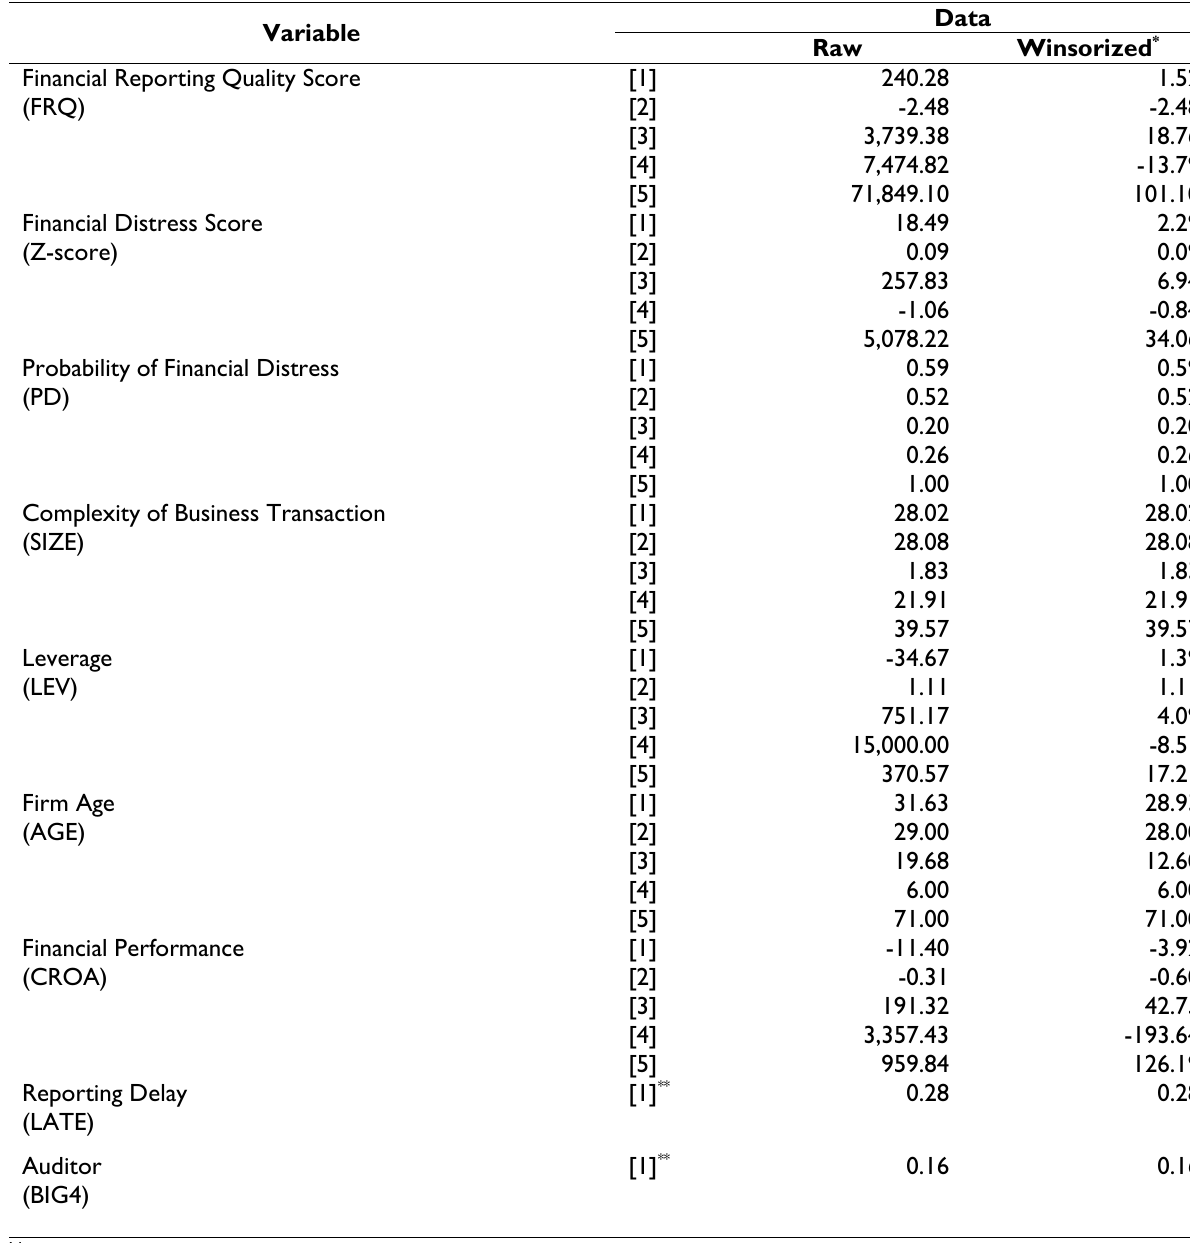
Table 2. Descriptive Statistics of Research Variables in the 2014-2020